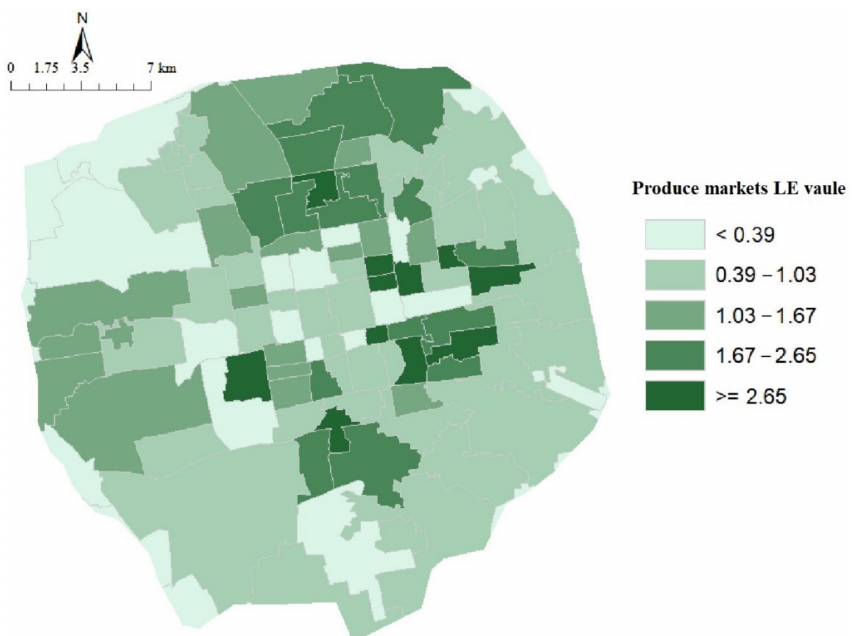
Figure 8. Distribution of the produce market locational entropy values for streets within the Fifth Ring Road in